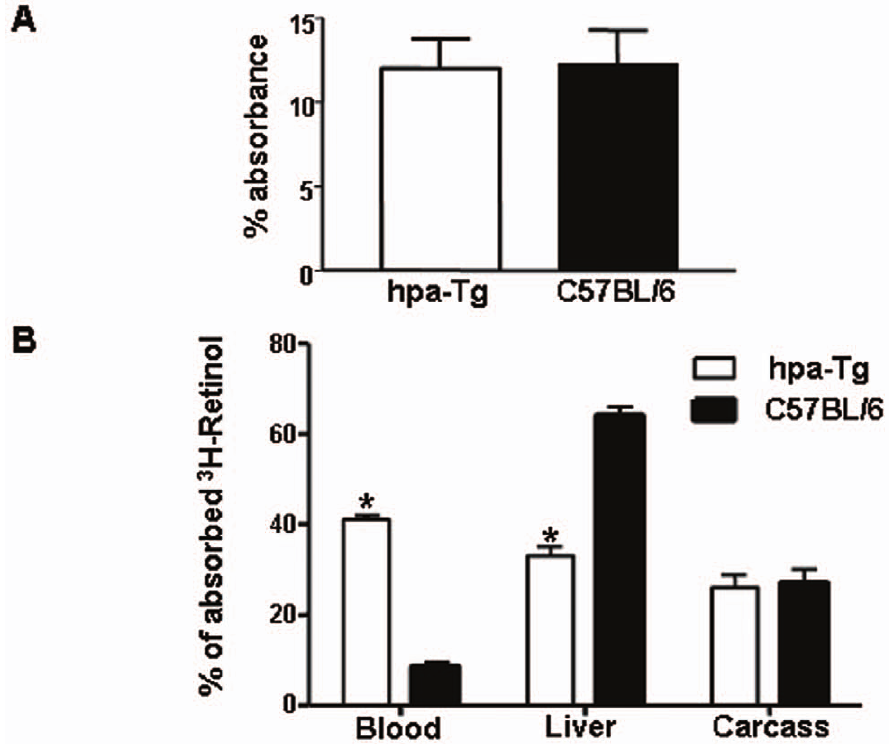
Figure 4. Post-prandial lipid handling in hpa-Tg and C57BL/6 mice. (A) Absorption of radio-labeled vitamin A ( 3 H-retinol). Intestinal absorption was 12% of the total administered dose of 3 H-retinol in both hpa-Tg (n=4) and C57BL/6 mice (n=4). (B) Distribution of absorbed vitamin A ( 3 H-retinol) in blood, liver and carcass. 41% of the radioactive retinol were detected in serum of hpa-Tg mice compared to 9% detected in serum of C57BL/6 mice, p , 0.0001. No difference was detected in radioactivity extracted from carcasses of the two experimental groups. The decrease in liver uptake of retinol was paralleled by an equivalent increase in the level of labeled retinol in the blood of hpa-Tg mice.